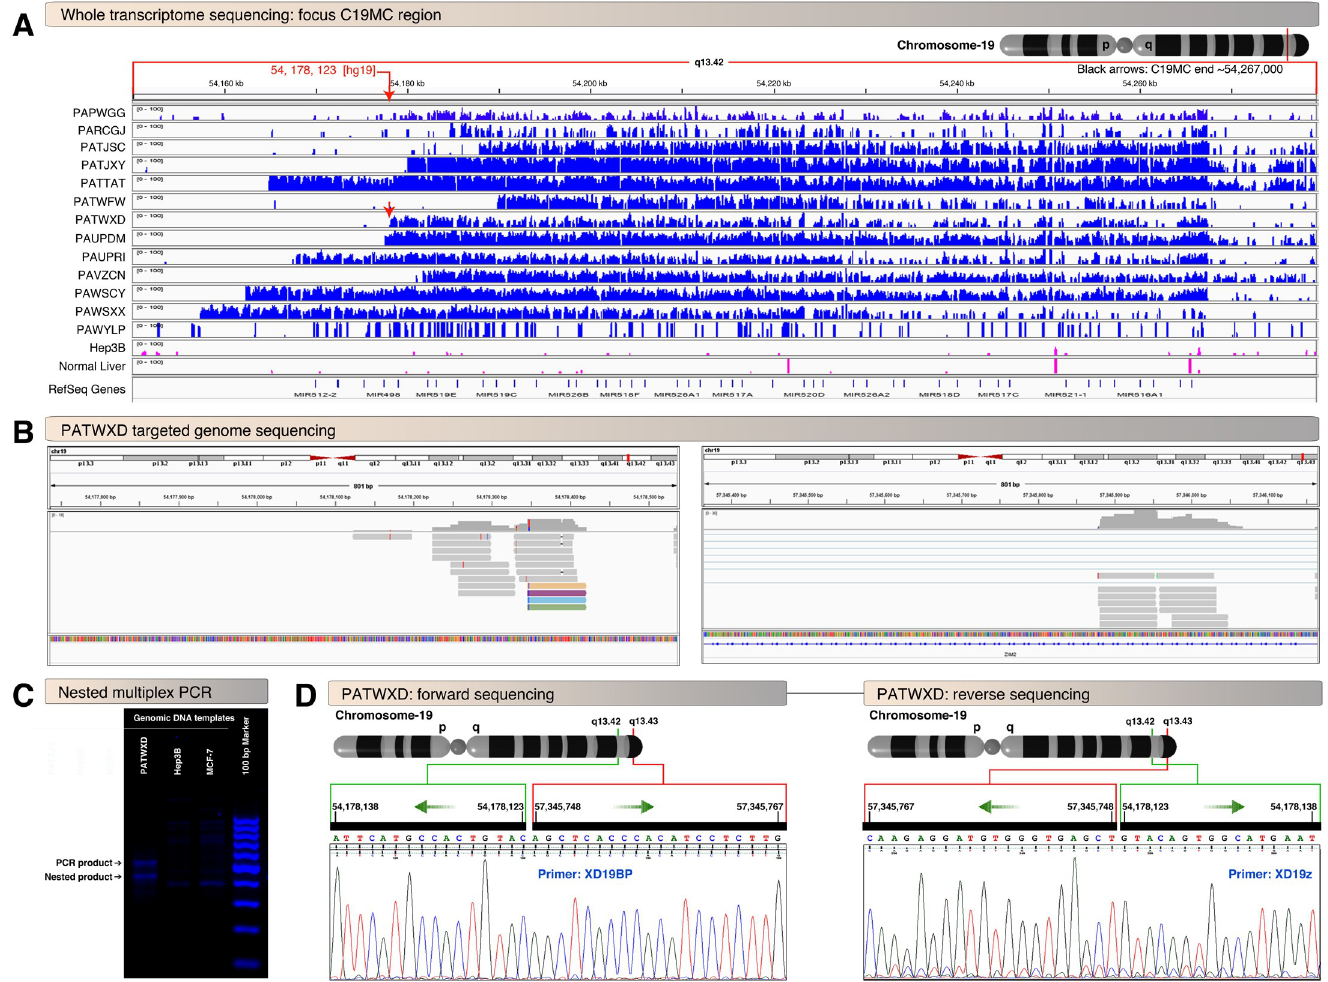
Fig 2. UESL display aberrant transcriptional activity of the C19MC region. A novel PEG3/ZIM2 -C19MC fusion is identified. A, Read counts of mapped whole transcriptome show high levels of aberrant transcriptional activity in the C19MC region. Note that the abrupt starting location of transcriptional mapping is in different co-ordinates in different UESL samples, suggestive of sample specific fusional events. The genomic position of the experimentally verified fusion in PATWXD is indicated by the red arrow in panel-A and notably corresponds to the start (5’ end) of transcriptional activity in this sample. Hep3B cell line (hepatocellular carcinoma) and normal liver samples are shown at the bottom for comparison and as expected show negligible amounts of RNA mapping to this non- coding region. B, Targeted DNA sequencing of PATWXD UESL tumor showing abrupt end of read mapping near the C19MC start site (left) as well as in the PEG2/ ZIM2 gene locus (right, shared gene region). The reads also mark the position of primers designed for gDNA PCR (one primer at 5’ end of reads and another at 3’end of reads for each locus (therefore one set of primers will form a nested primer set). C, Nested multiplex PCR of PATWXD genomic DNA showing amplicon (~550 bp) including the nested product (~450 bp). D, Paired end Sanger sequencing of ~550 bp product from panel-B showing the PEG3/ZIM2 locus fused to C19MC aberrant transcriptional start